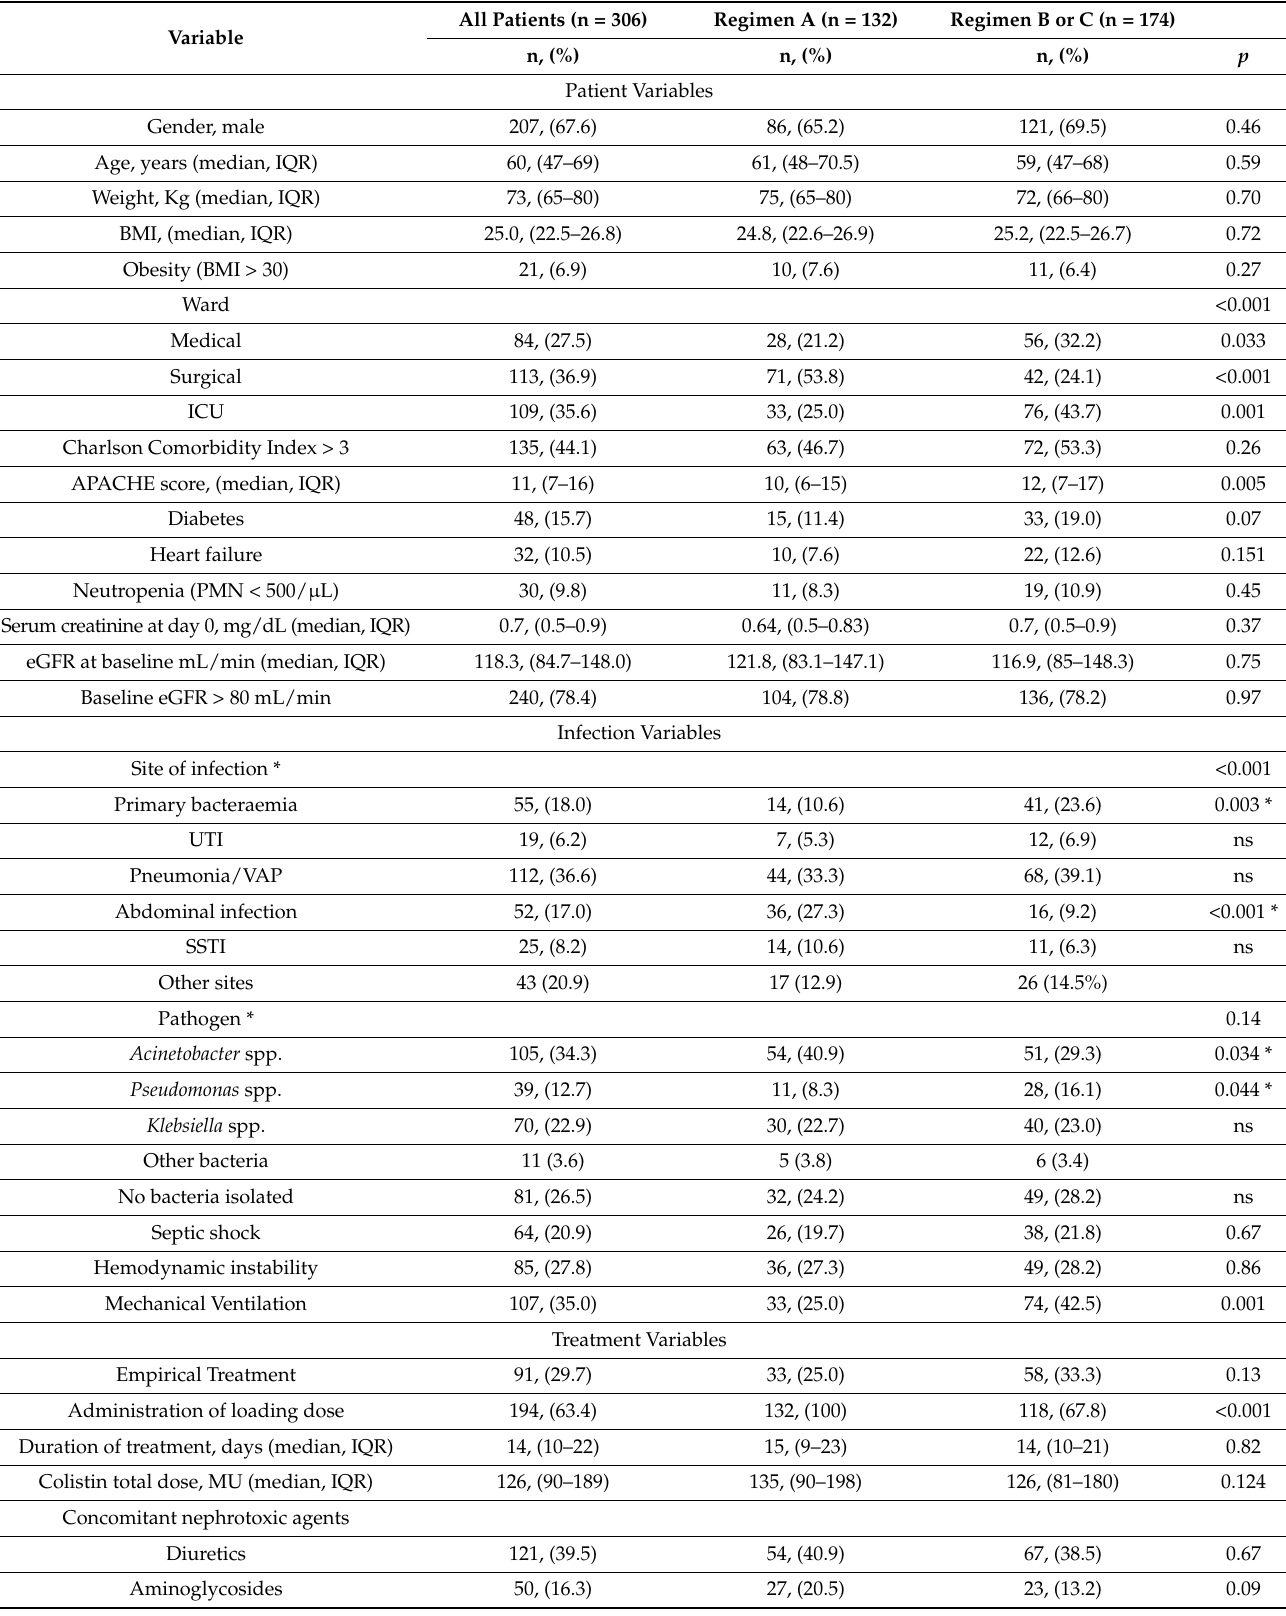
Table 1. Patient characteristics by dosing scheme in the full